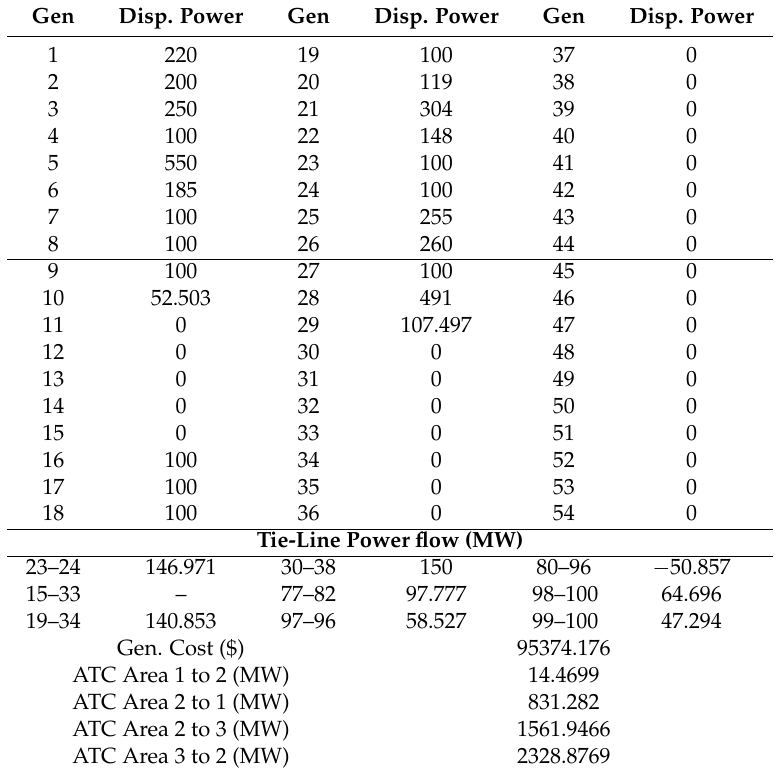
Table 8. ATC and Gen. Dispatch Results in IEEE 118-bus system with line 15–33 outage.